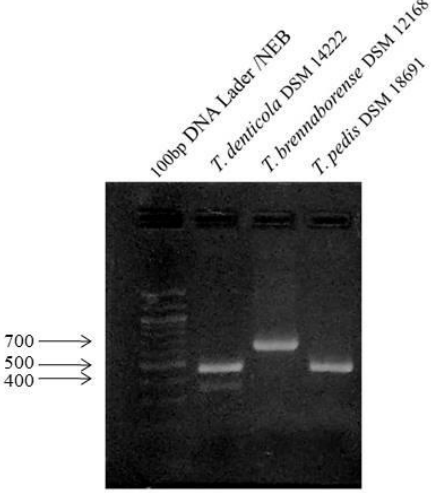
Figure 1. Detection of positive controls on agarose gel after amplification.